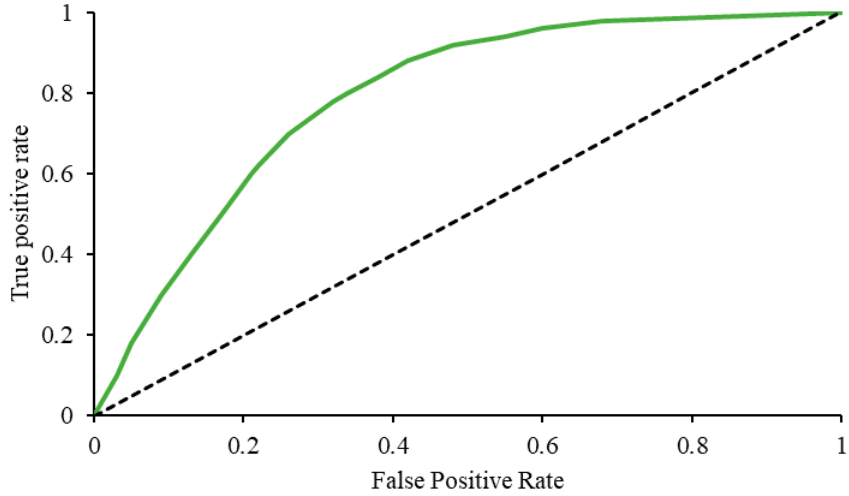
Figure 11. Receiver operating characteristic (ROC) curve of the susceptibility map by